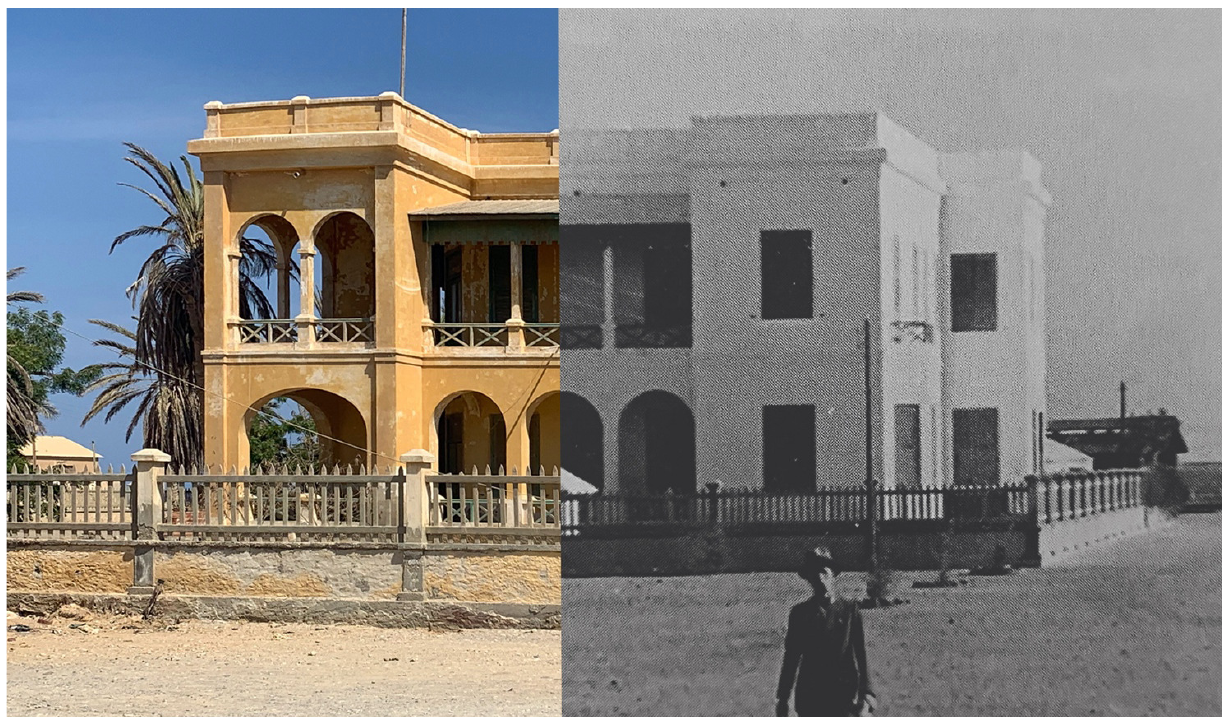
Figure 10. The Casa amministrazione, probably during the 1930s (right), now locally known as the King Farouk Rest House (left). Sources: Project fieldwork (2022; left) and Pellegrini (2011, p. 77;